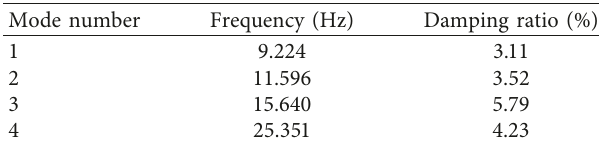
Figure 14: The frequency response function obtained from the EFDD technique. Table 3: Modal parameters of masonry building under tunnel blasting